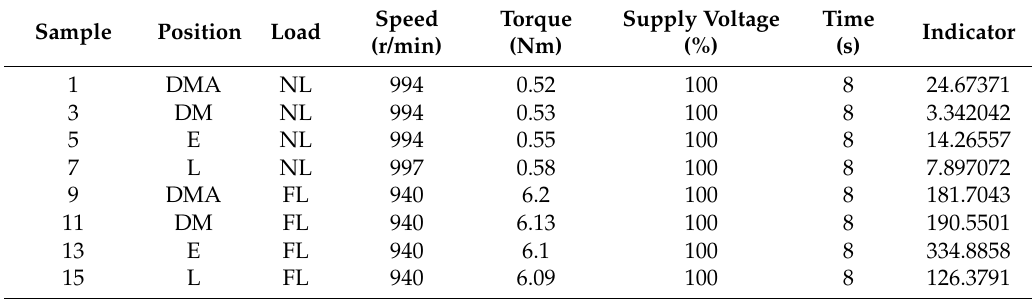
Table 13. Results of the indicator, based on Equations (6)–(8), for the data of the faulty motor experiments under the steady state regime.